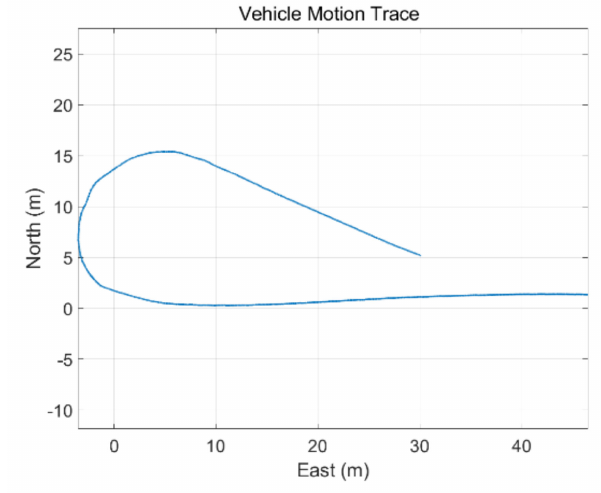
Figure 8. The skid-steered wheeled vehicle moving trace when it turns. Figure 9 shows the longitudinal state of the vehicle when it turns. The two estimation algorithms show almost no difference when the longitudinal velocity changes slightly. The longitudinal slip rate of the right side is positive becuse the right left is the outside wheels which are in the skidding condition. Similarly, the left side is the inside wheels which are in the slipping condition. When a skid-steered wheeled vehicle turns, the speed difference between the wheels on the sides would lead to a large tire slip rate even though the vehicle is moving on the ground with a high adhesion